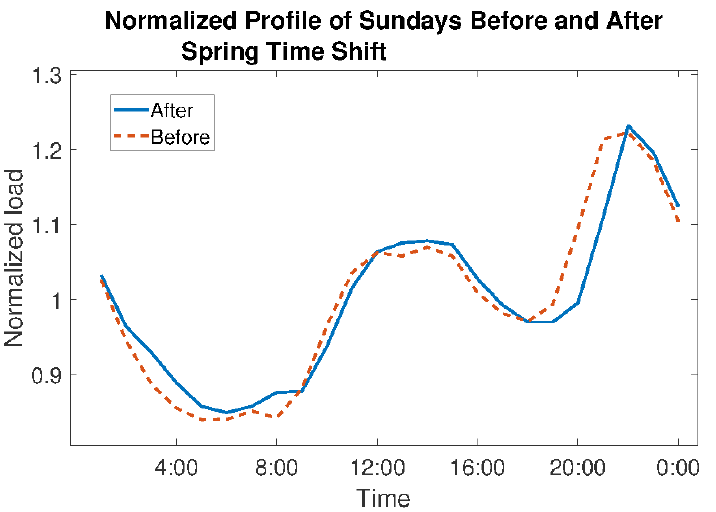
Figure 2. Normalized profiles of the Sunday before and after the daylight savings time (DST) time shift in